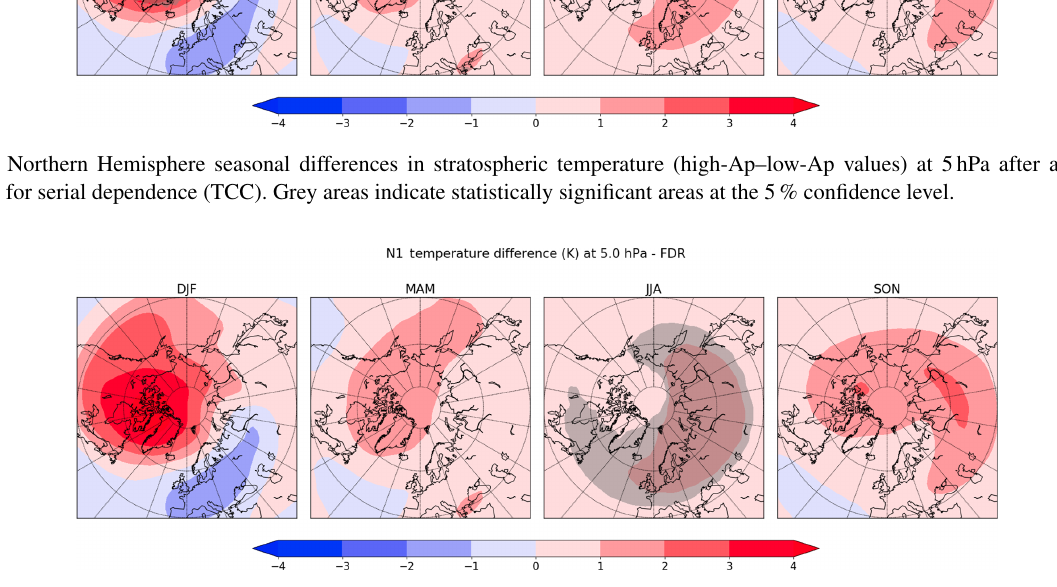
Figure 4. Northern Hemisphere seasonal differences in stratospheric temperature (high-Ap–low-Ap values) at 5hPa after applying the FDR correction. Grey areas indicate statistically significant areas at the 5% confidence level – before FDR